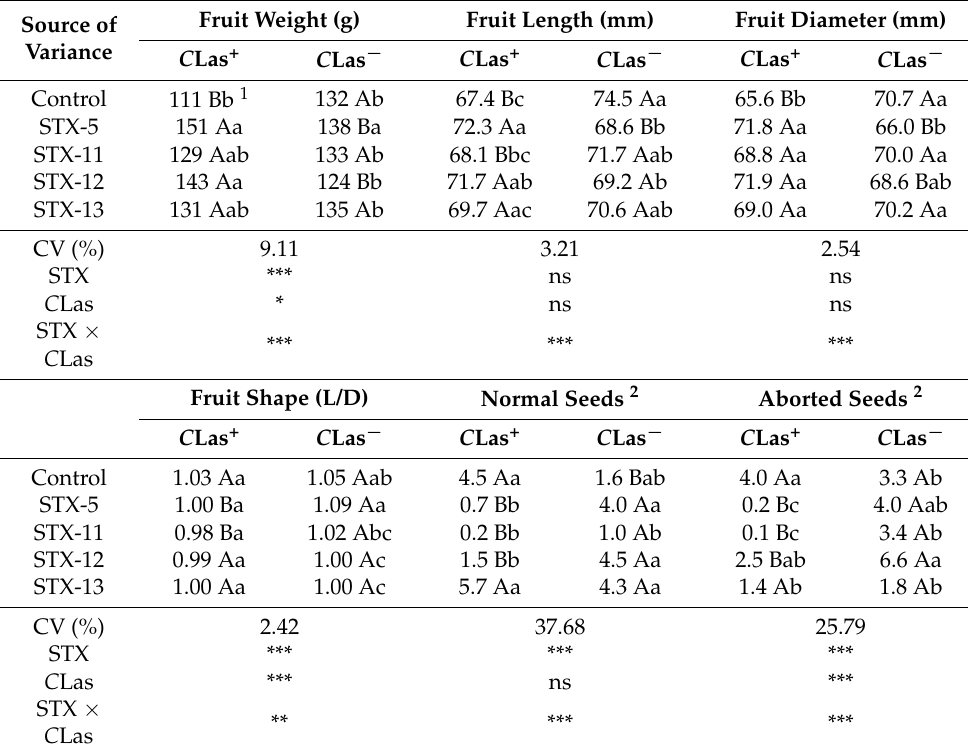
Table 1. Fruit quality of ‘ Candidatus Liberibacter asiaticus’ ( C Las + )-inoculated and non-inoculated ( C Las − ) STX IA transgenic and non-transgenic control plants of Pera sweet orange ( Citrus × sinensis ).